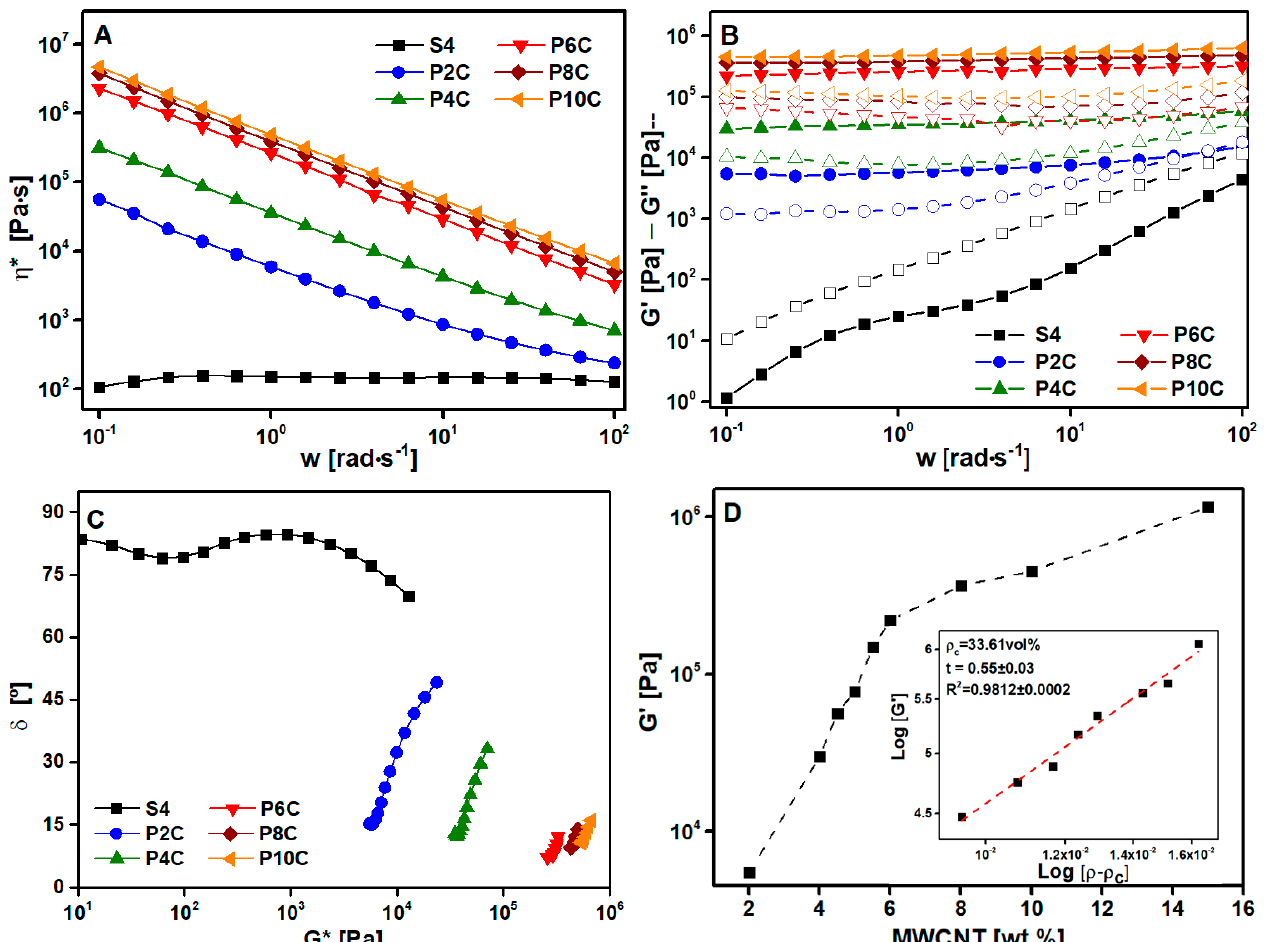
Figure 5. ( A ) Complex viscosity ( η *) as frequency function, ( B ) frequency sweep test of dynamic storage and loss modulus, in which the closed marks are G ′ and the open ones are G ″ , ( C ) van Gurp– Palmen graphic and ( D ) rheological threshold for composites with different MWCNT concentration and its linear fit adjustment (inset).